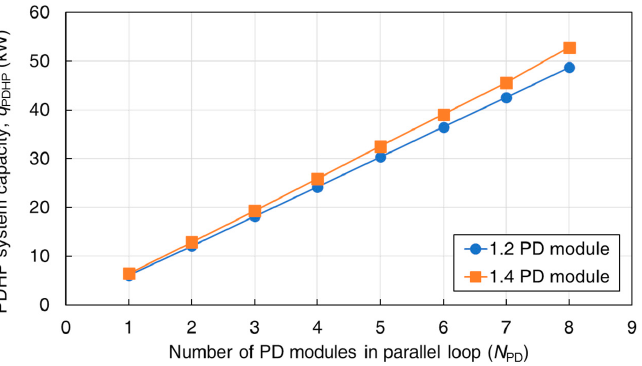
Figure 11. PDHP system capacity according to the number of PD modules in parallel loop.